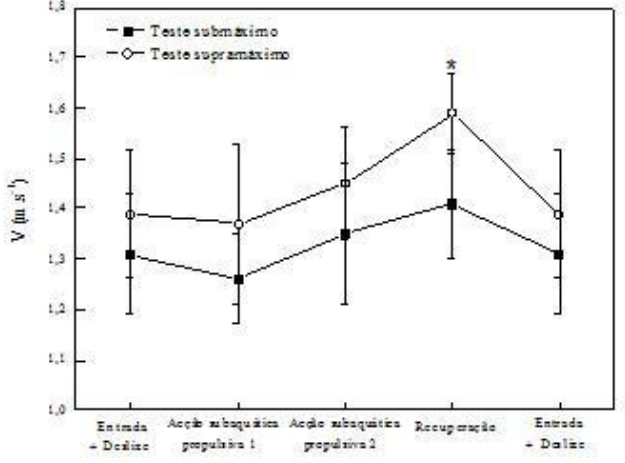
Figura 5. Velocidade de deslocamento do centro de massa (V) durante um ciclo gestual dos